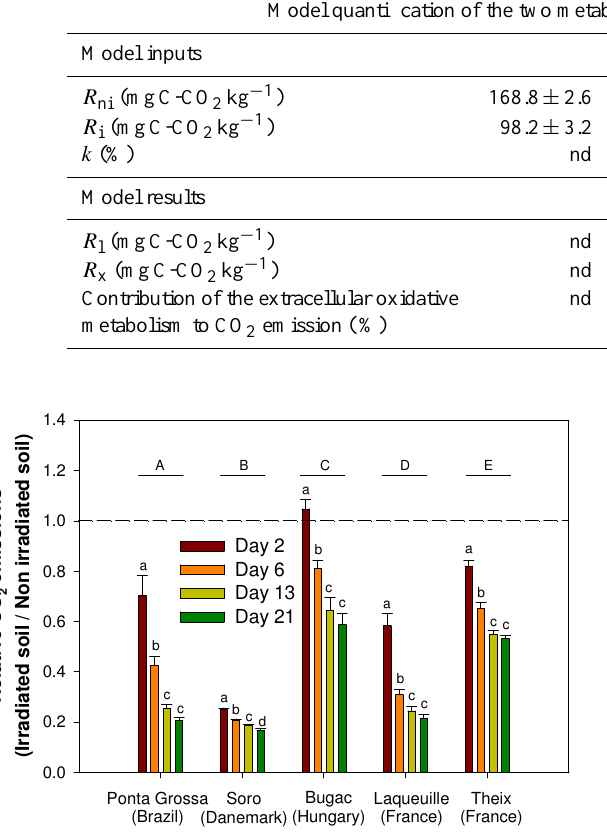
Fig. 4. Relative CO 2 emission between irradiated and non- irradiated soil for the five studied soils. Day 2, Day 6, Day 13 and Day 21 represent days of incubation. Letters indicate the differ- ences at 5% level between measurements over time (lower case) and across soils (upper case) based on repeated-measures analysis of